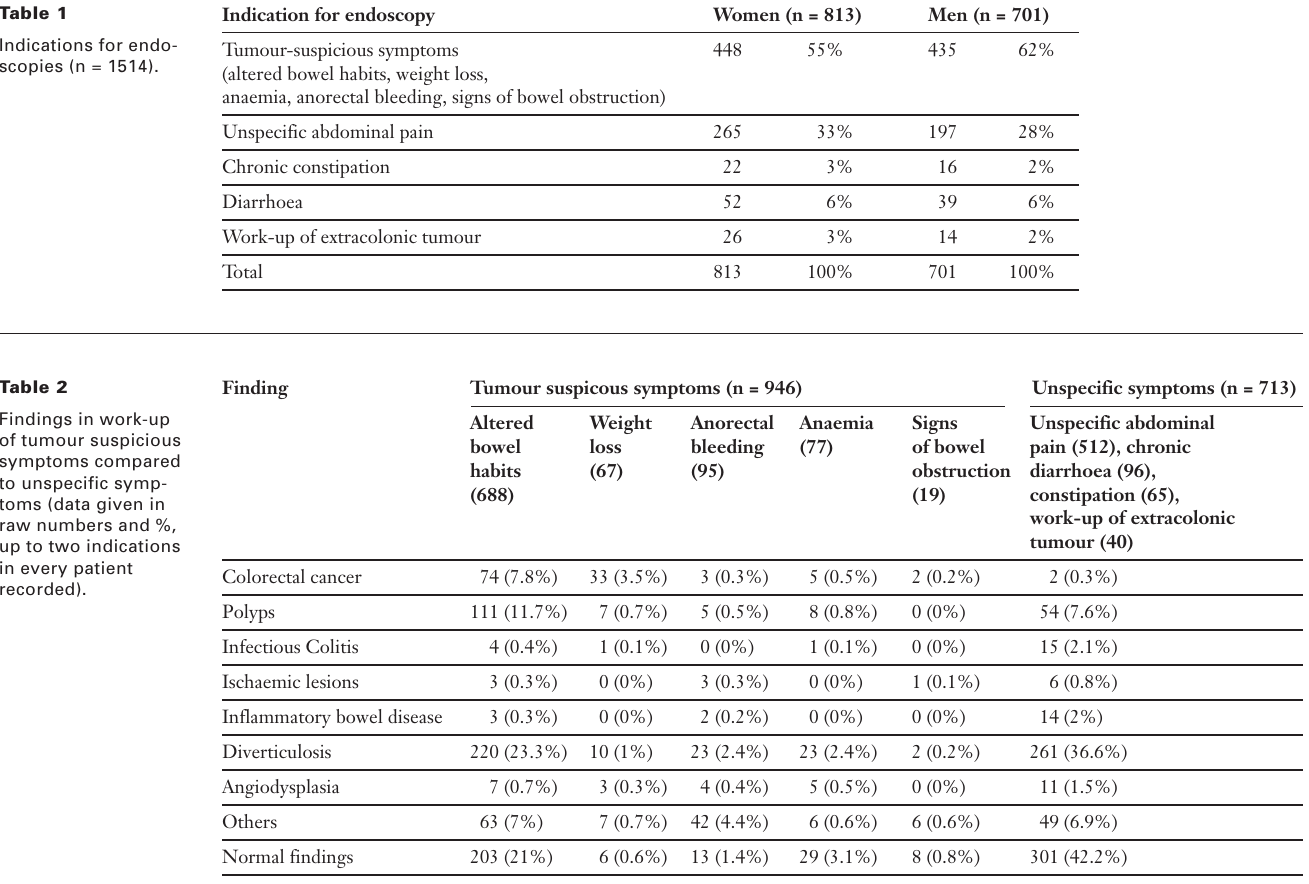
Table 1 Indications for endo- scopies (n = 1514).